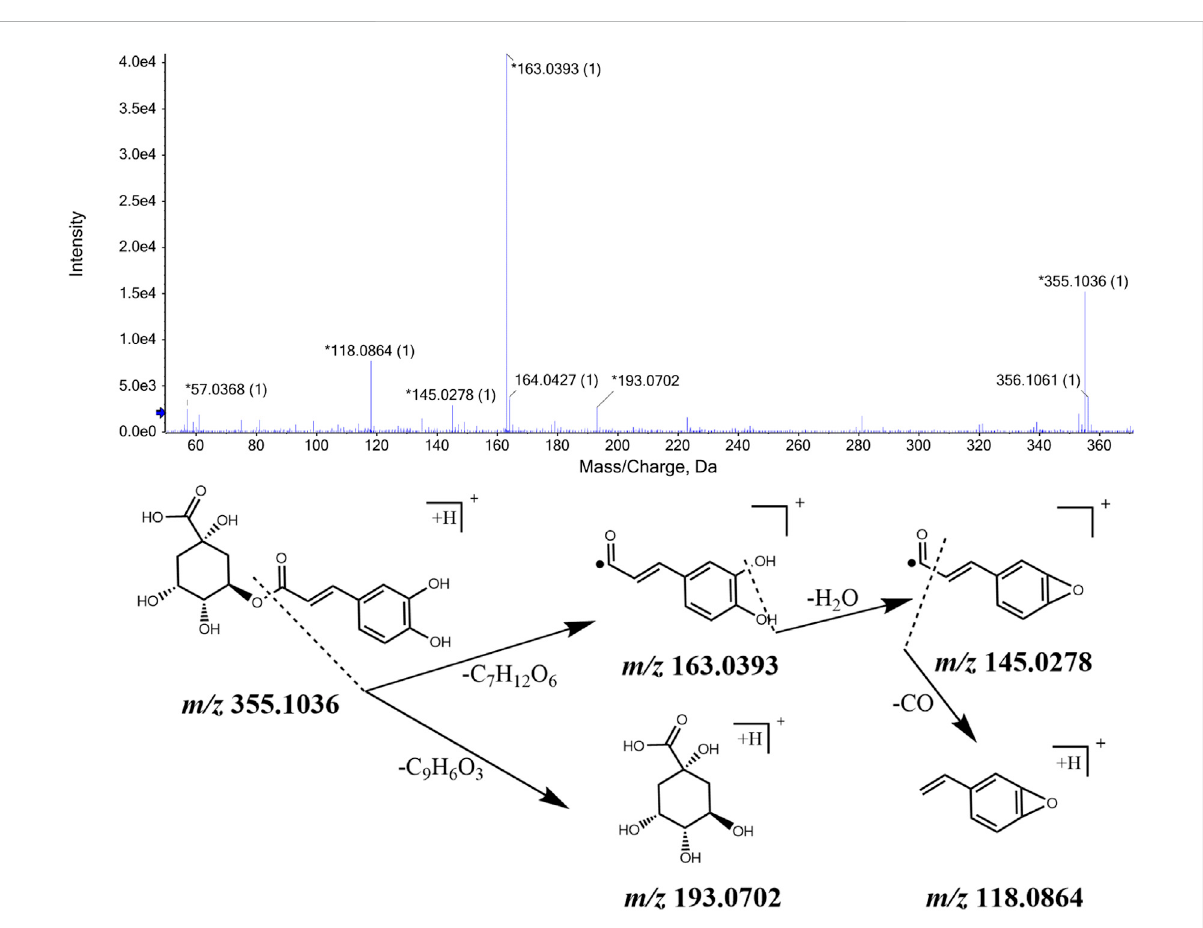
FIGURE 2 MS/MS spectrum of chlorogenic acid in CWT and speculated fragmentation